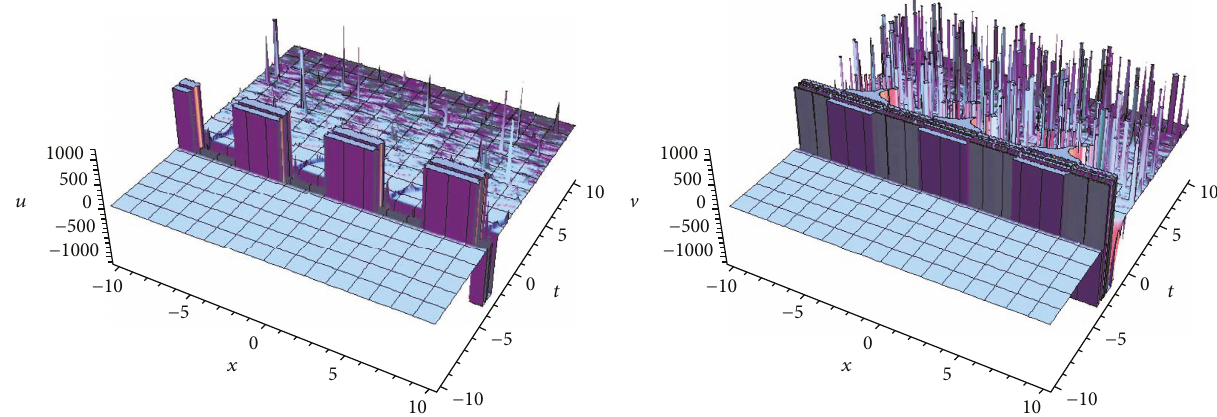
Figure 1: Spatial structures of solutions (24) and (25) determined by (51).